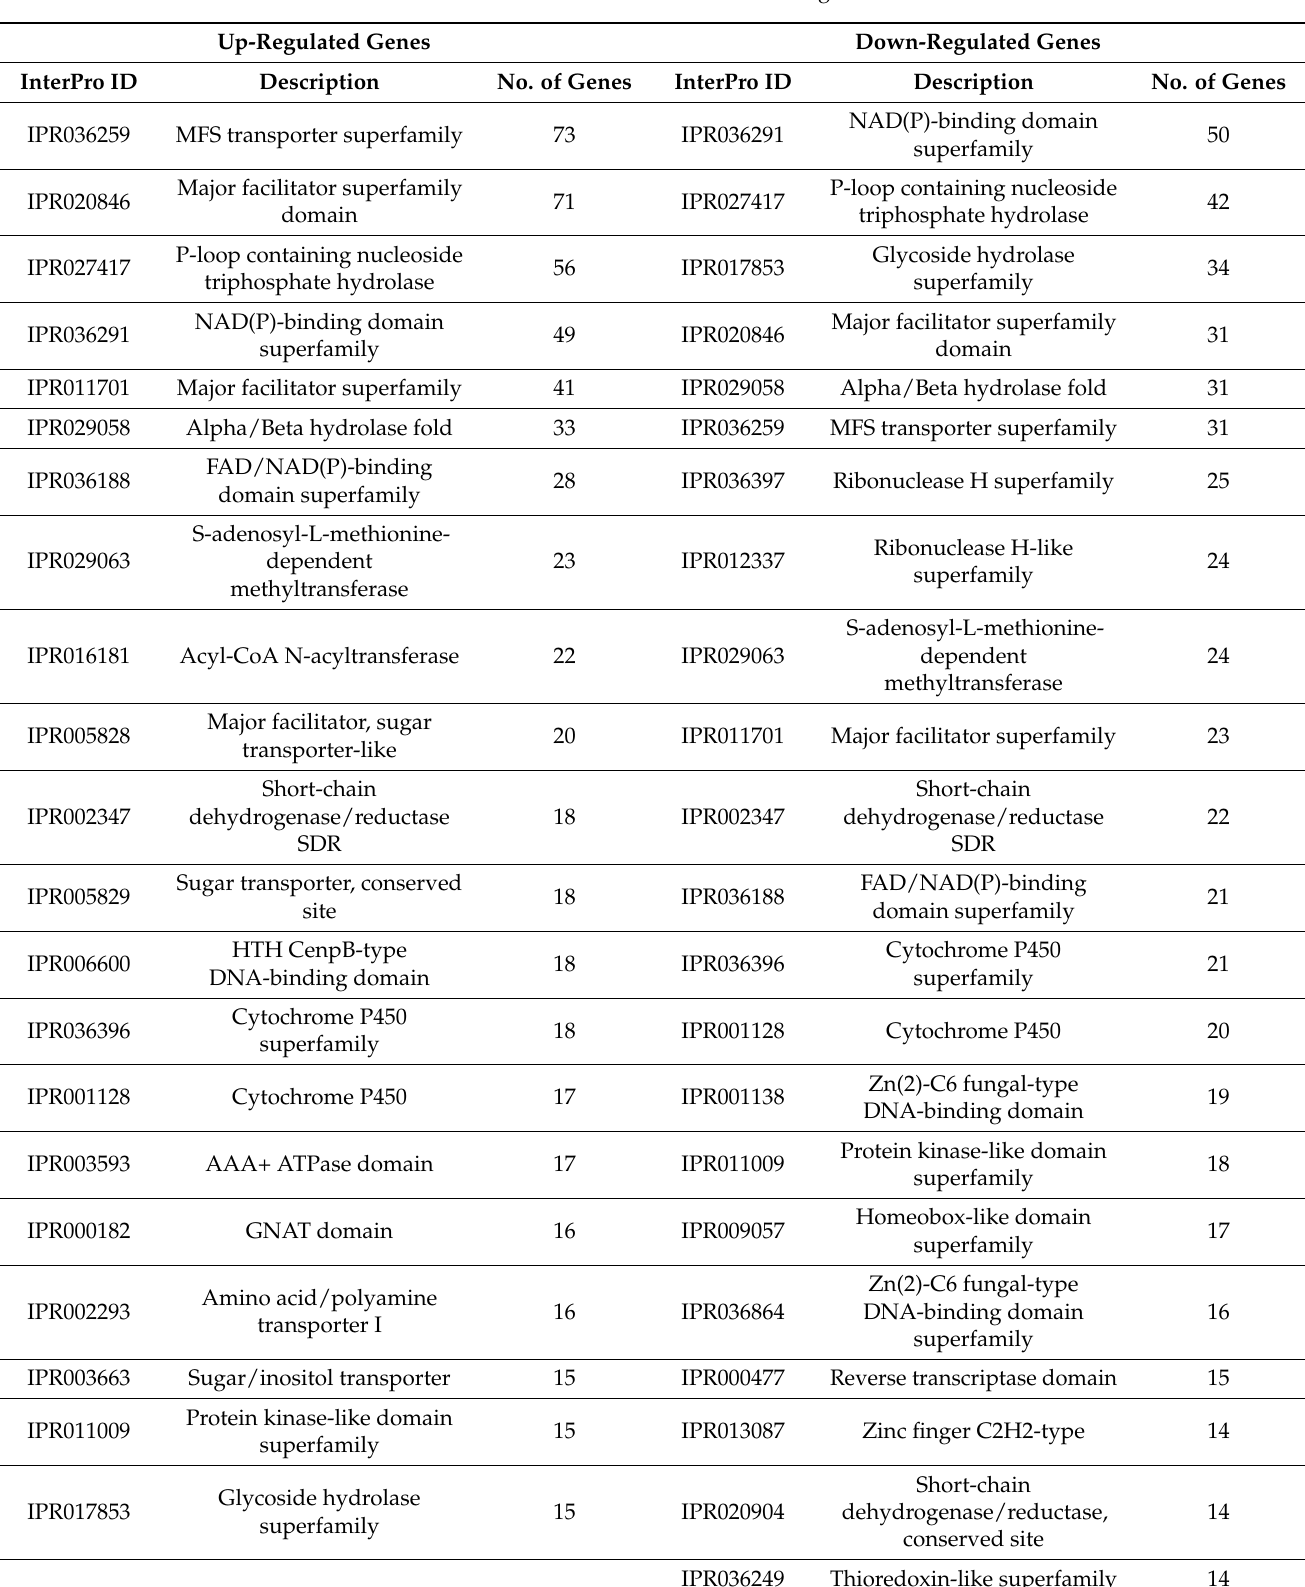
Table 1. The most abundant InterPro domains according to the